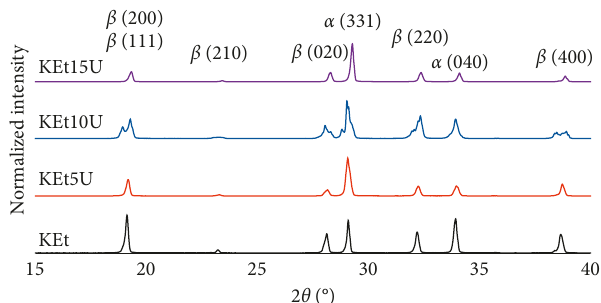
Figure 6: X-ray diffraction patterns for the KEtU series assisted in recrystallization with ultrasound at 5, 10, and 15min of irradiation compared with the KEt sample without treatment.